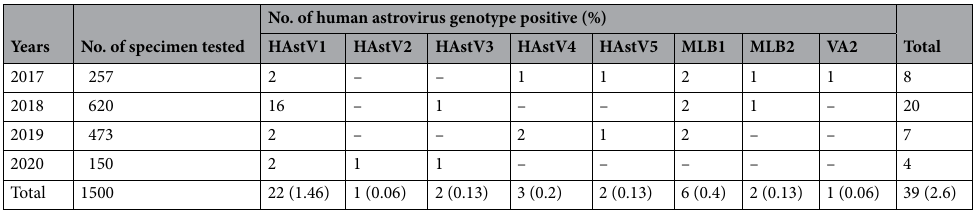
Table 2. Distribution of HAstV genotypes in children hospitalized with acute gastroenteritis in Chiang Mai, Thailand during 2017–2020.